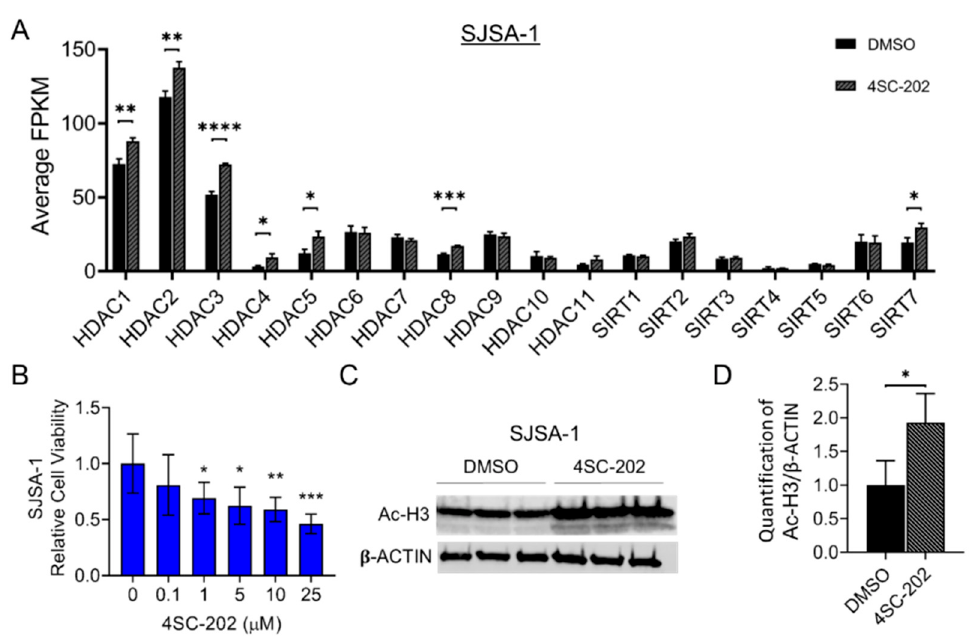
Figure 1. Impact of selective pharmacological inhibition of class I histone deacetylases with 4SC-202 on human SJSA-1 OS cells. ( A ) Gene expression of 18 histone deacetylases (HDACs) in SJSA-1 cells. Average FPKM (i.e., fragments per kilo base per million mapped reads) values generated from RNA-seq analysis of indicated genes from 3 samples treated with DMSO vehicle (dark bar) and 3 samples treated with 4SC-202 (grey bar). ( B ) 4SC-202 effect on cell proliferation and viability treated with increased concentration of 4SC-202 for 24 h. Statistical significance comparing each treated group to the control was analyzed using GraphPad software with one-way ANOVA (Holm method). ( C ) Representative Western blot analysis of Ac-H3 and β -ACTIN in DMSO-treated and 4SC-202-treated conditions in OS cells. ( D ) Densitometric quantification of the blots of protein band intensity of Ac-H3 normalized to housekeeping β -ACTIN bands. Number of asterisks indicates level of statistical significance between groups. * p < 0.05, ** p < 0.01, *** p < 0.001, **** p < 0.0001. Data are presented as mean (SD).